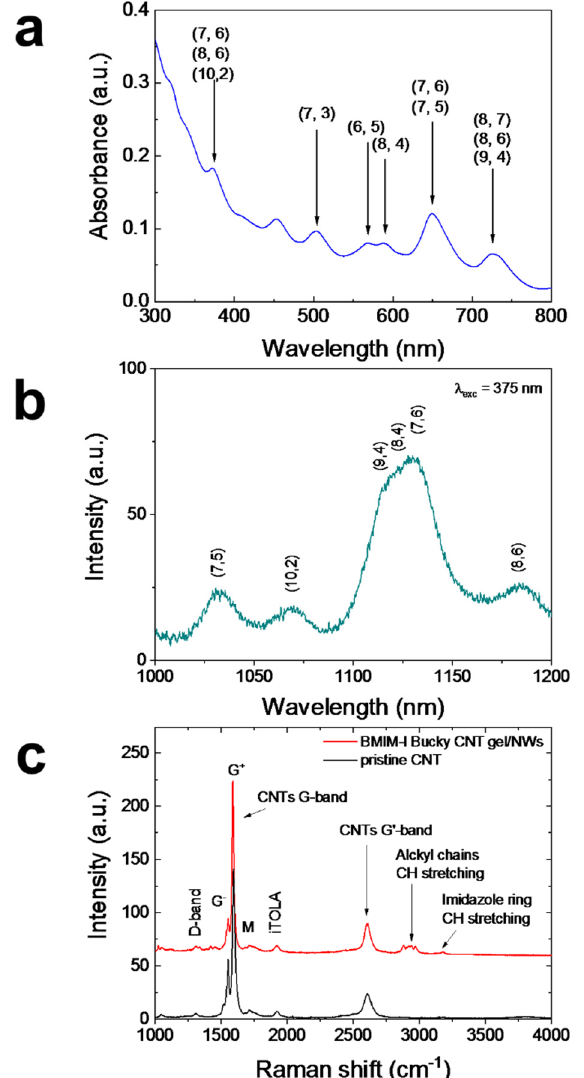
Figure 4. ( a ) UV-VIS absorption spectrum and ( b ) room temperature photoluminescence at 375 nm excitation spectra of the BMIM-I CNT Bucky gel with a concentration of 5.7 mg/mL. ( c ) Raman spectra of pristine CNT enriched in chirality (7,6) in black and the hybrid platform of CNT bucky BMIM-I gel applied onto the NWs in red, reported in the 1000–4000 cm − 1 window of interest for the organic C-based bonds. The upper inset shows the SEM image of the NWs covered with the CNT gel.